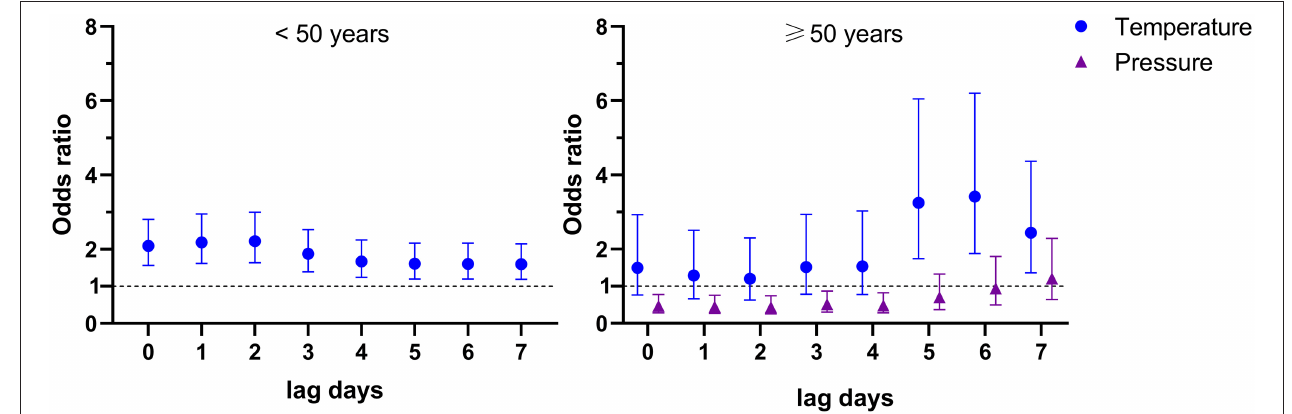
FIGURE 3 | Environmental variables significantly associated with talaromycosis in younger ( < 50 years) and older patients ( ≥ 50